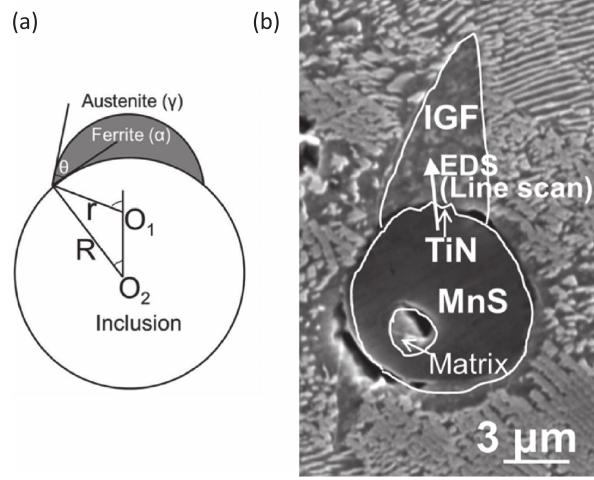
Figure 11: (a) Schematic geometry and (b) SEM observation of IGF nucleation on a spherical cap nuclei inclusion [10].